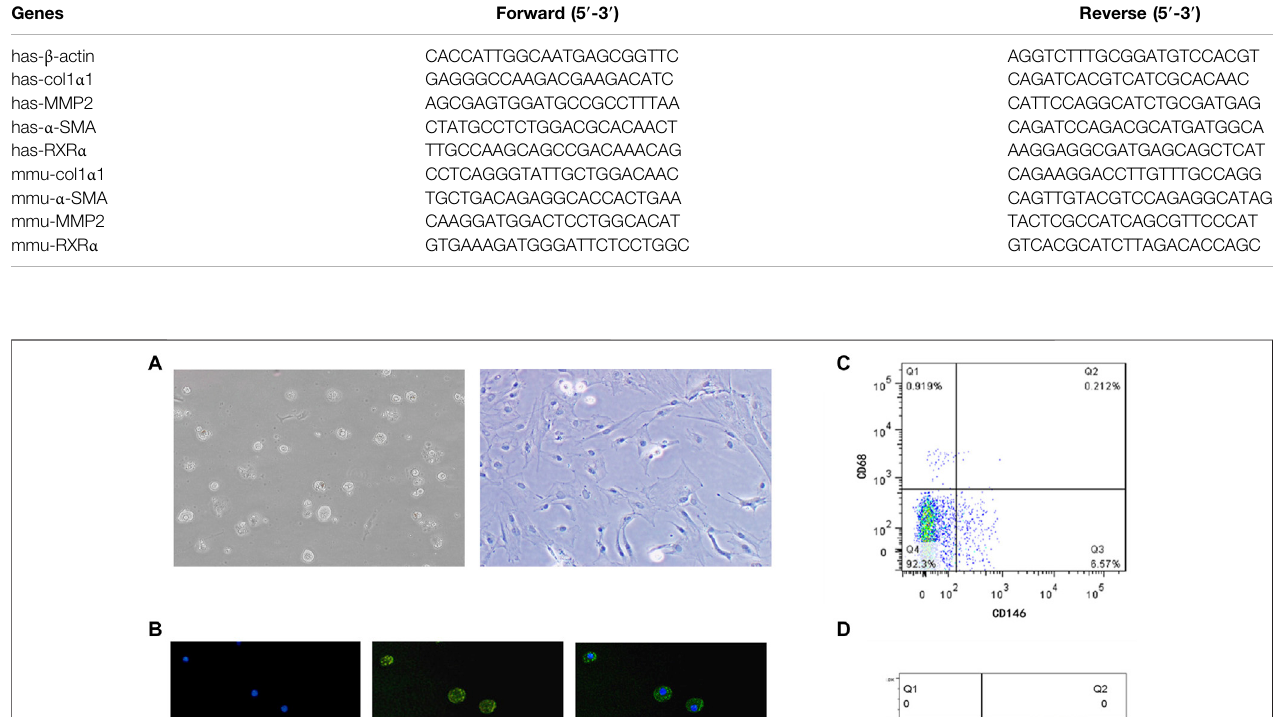
Frontiers in Cell and Developmental Biology |